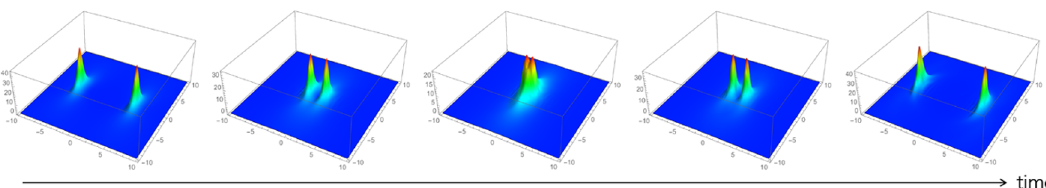
Figure 9 . Evolution of energy density for the two anti-parallel vortices scattering with u = 0 . 85